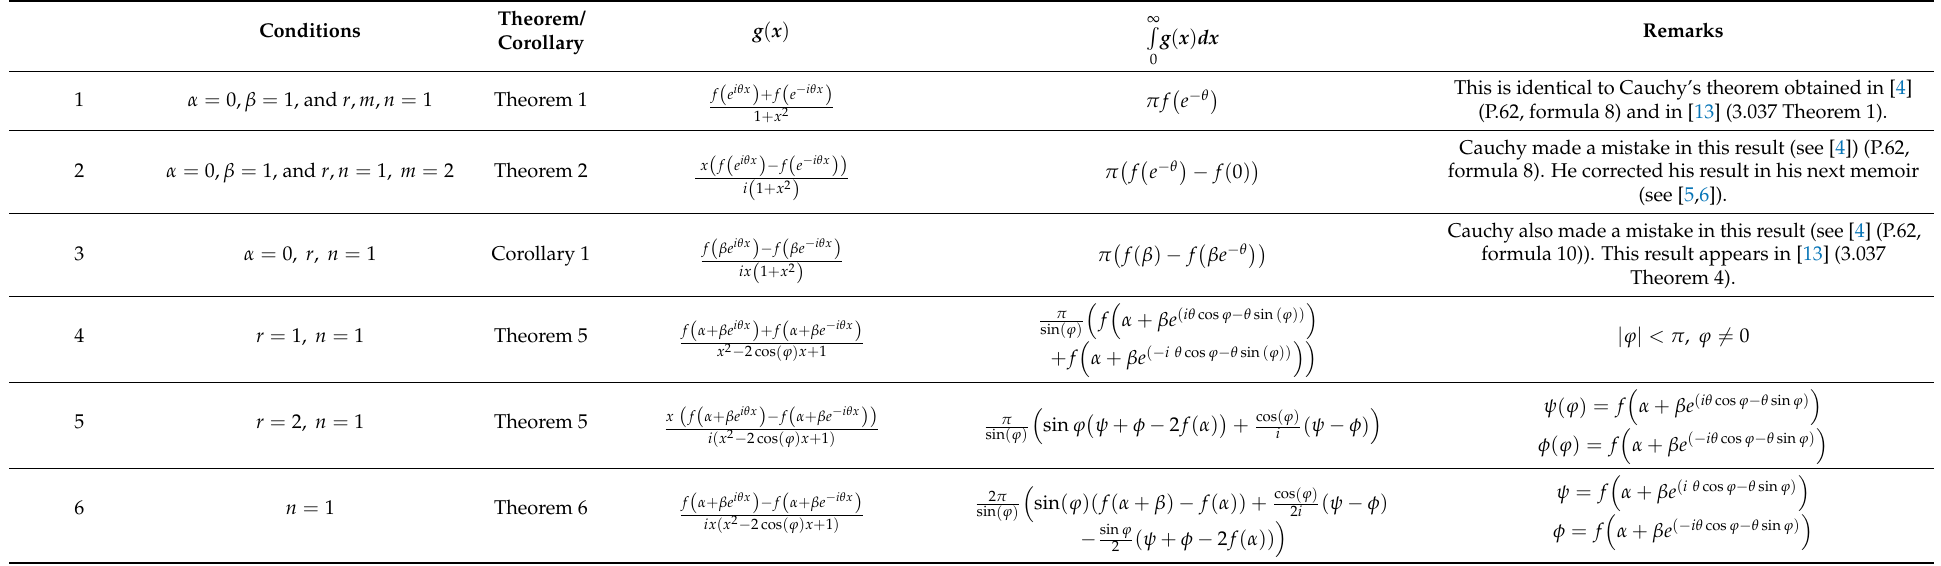
Table 1. Remarks on improper integrals, where θ >